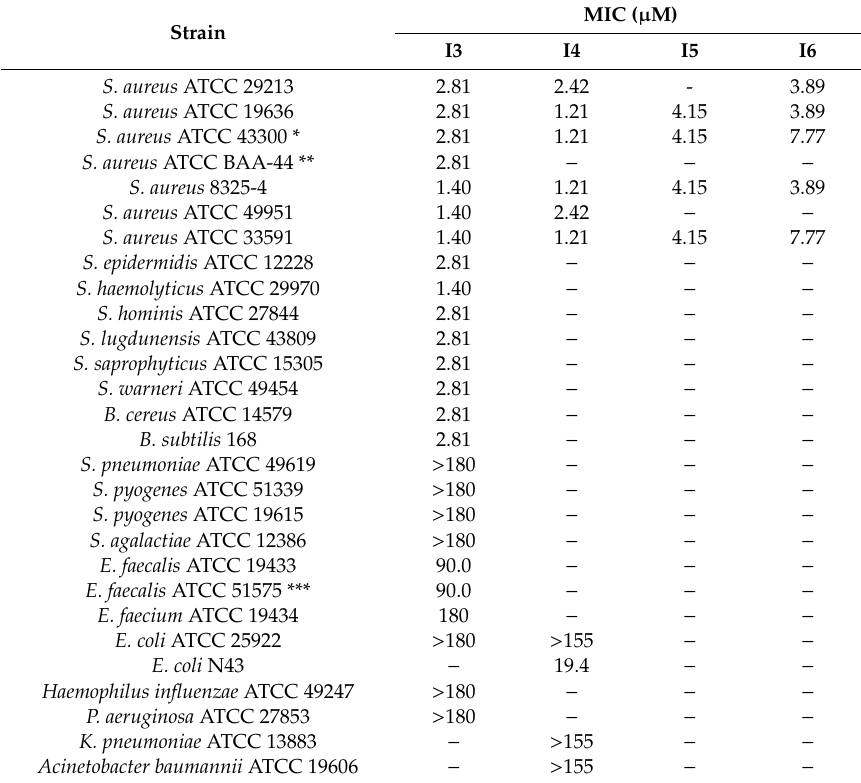
Table 6. MICs of benzamides